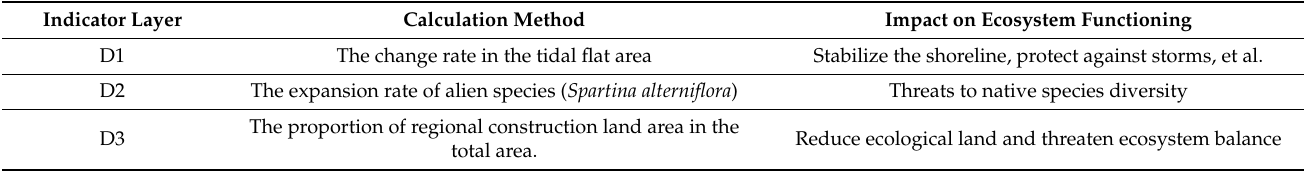
Table A1. Detailed introduction of ecosystem stability evaluation